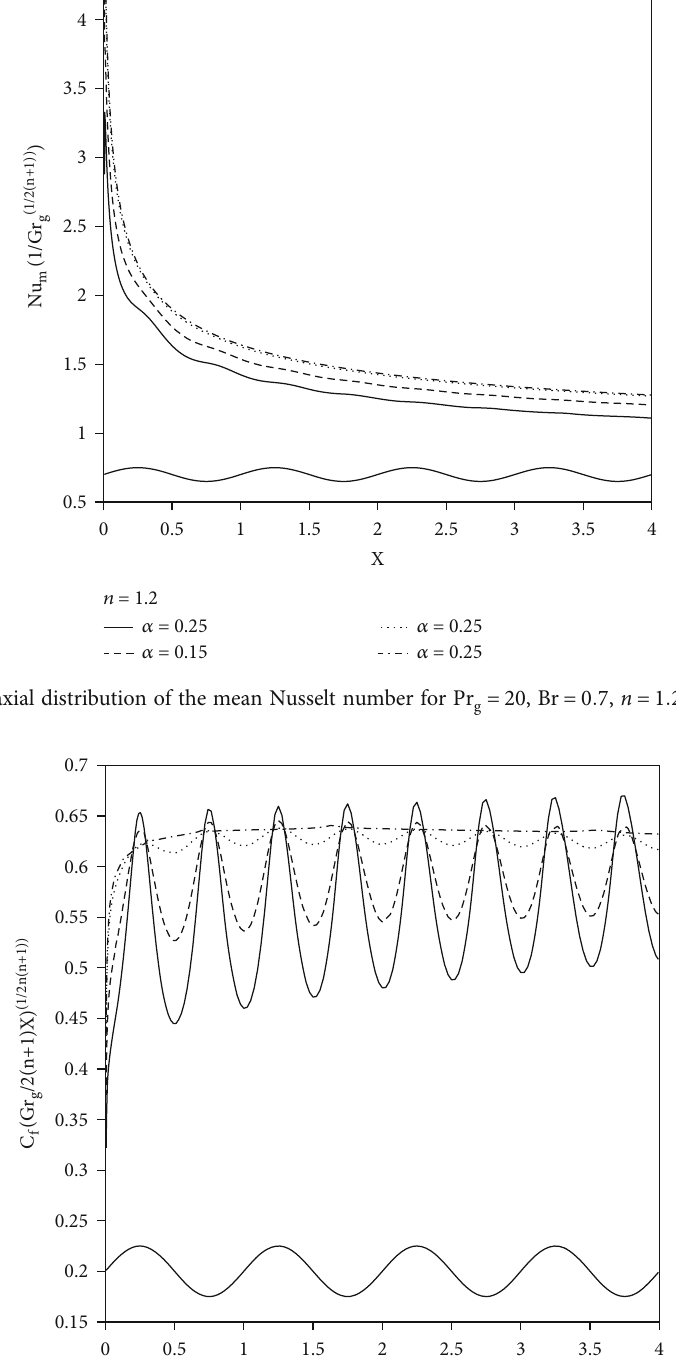
= 20 , Br = 0 : 7 , n = 1 : 2 , and Q = − 0 : 05 g